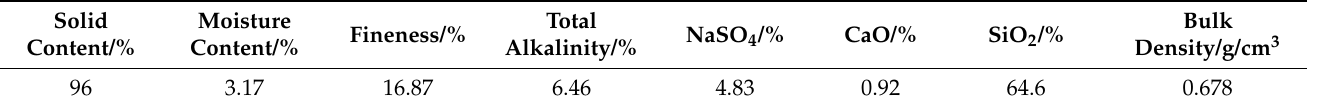
Table 1. Performance parameters of Jiuherun brand additive agent.